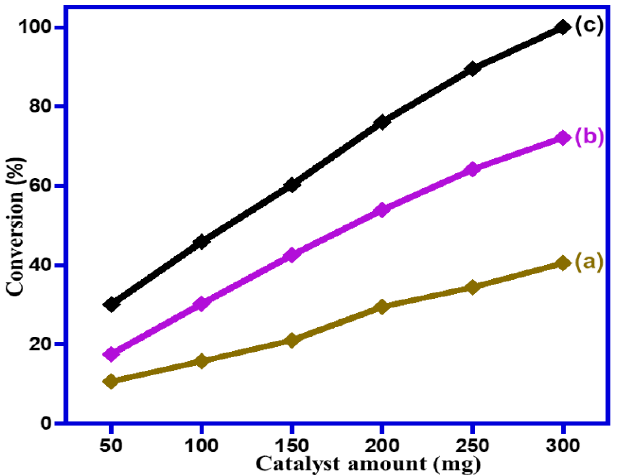
Figure 10. Impact of varying catalyst dosage on the PhCH 2 OH conversion over ( a ) MnCO 3 , ( b )